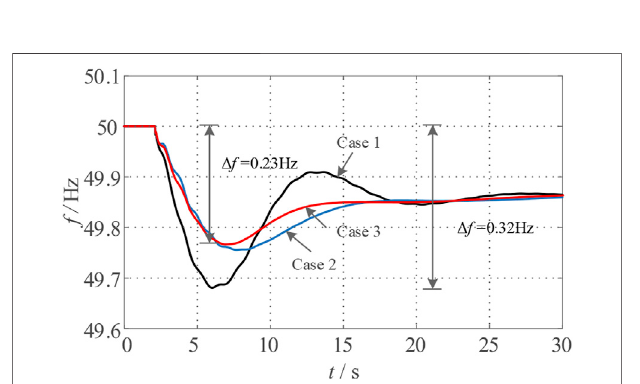
FIGURE 9 | Frequency responses of the system after the load